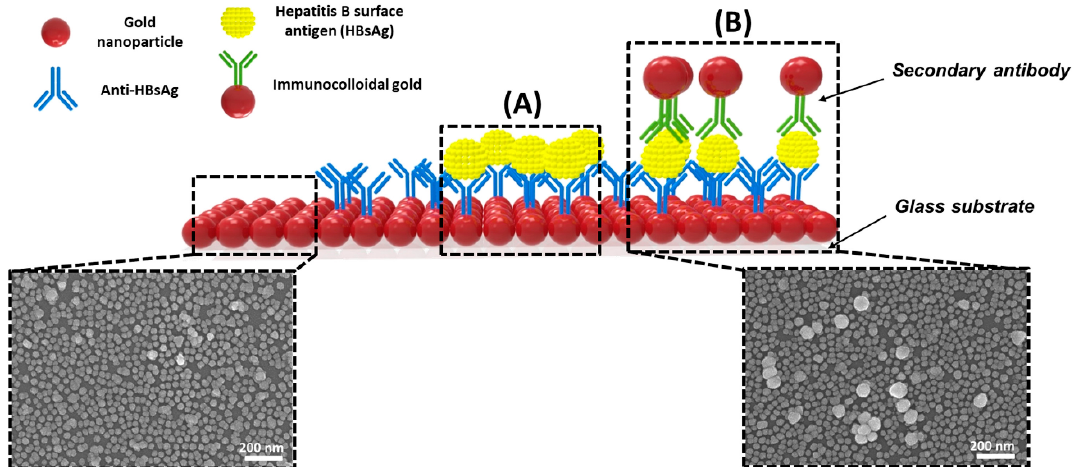
Figure 8. Detection of HBsAg by single assay LSPR sensing chip format ( A ) and modified heteroassembled AuNP sandwich immunoassay LSPR chip format using immunocolloid AuNPs ( B ). Changes in the spectrum peak at different concentrations of HBsAg (1 pg/mL to 1 µg/mL HBsAg), reacted on the chip. Insert image is presenting the immunological reaction occurring on the active site of LSPR sensing chip. 15, 30 and 50 nm of immunocolloid AuNPs as signal enhancers. 1 ng/mL to 100 fg/mL HBsAg reacted the LSPR chip. All experiments were conducted in six measurements, and data represent the mean ± standard deviation. The coefficient of variation (% CV) is below 10%. Reprinted with permission obtained from [101] .